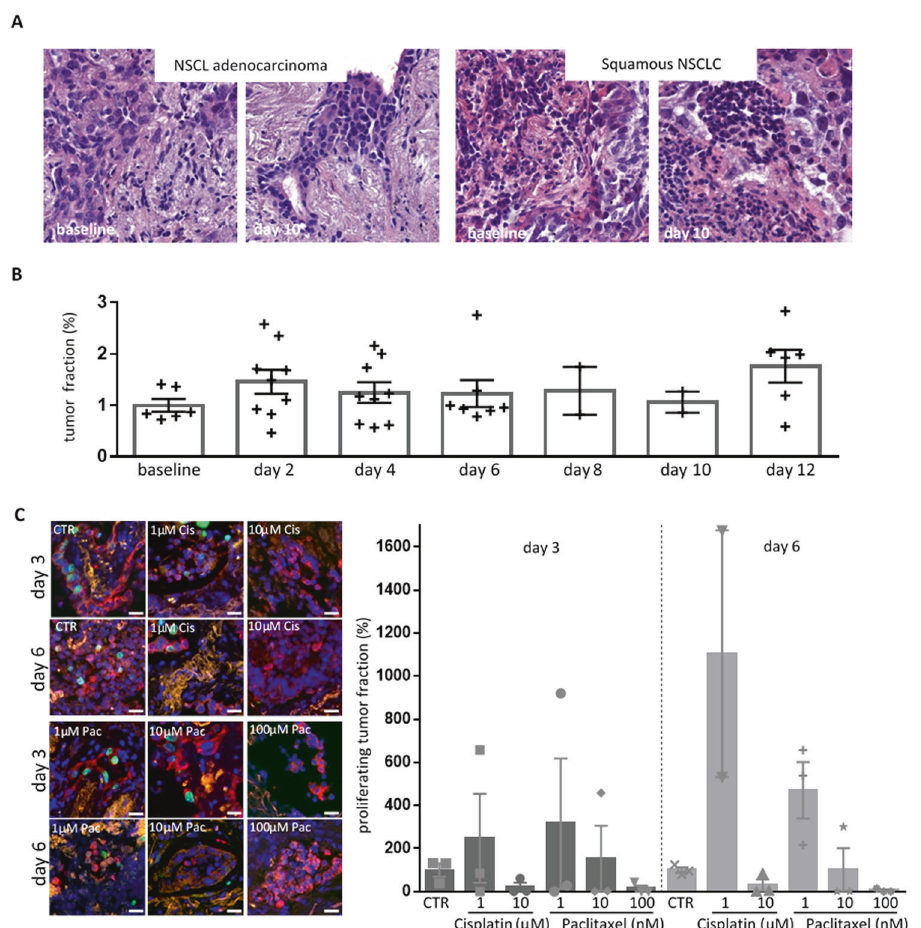
Fig. 1 Tissue maintenance and dose-dependent response ex vivo. A Slices from tumor specimen were stained with HE at baseline or after culture in control conditions for up to 12 days. Shown are representative HE staining of the two different NSCLC subtypes at baseline and after 10 days ex vivo. B The tumor fraction present in the cultured specimens was evaluated and normalized to the baseline. Shown are the results from three different patients. To control reproducibility multiple slides from the same patients were measured at the same timepoint. C Slices were cultured for 3 or 6 days with different doses of cisplatin (1, 10 µM) or paclitaxel (1, 10, 100 nM). To calculate the proliferating tumor fractions tissues were stained for Ki67 (green), pancytokeratine (red), and counterstained with Hoechst (blue). Shown are pictures of the different treatment at day 3 and 6 (right) as well as the overall variations in proliferating tumor fraction within the one tissue specimen for which enough material was available to perform all conditions with at least two replicates (left). Background, yellow; Bar = 50 µm.